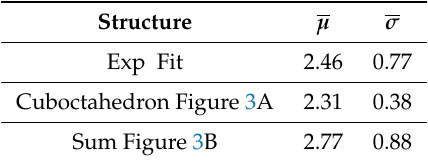
Figure 3. ( A ) Mass activity for cuboctahedra. ( B ) Mass activity versus D for adsorption on platinum polyhedra. Table 5. Mean, µ , and standard deviation, σ , for the platinum oxygen reduction reaction (ORR) mass activity for Figure 3, using a lognormal